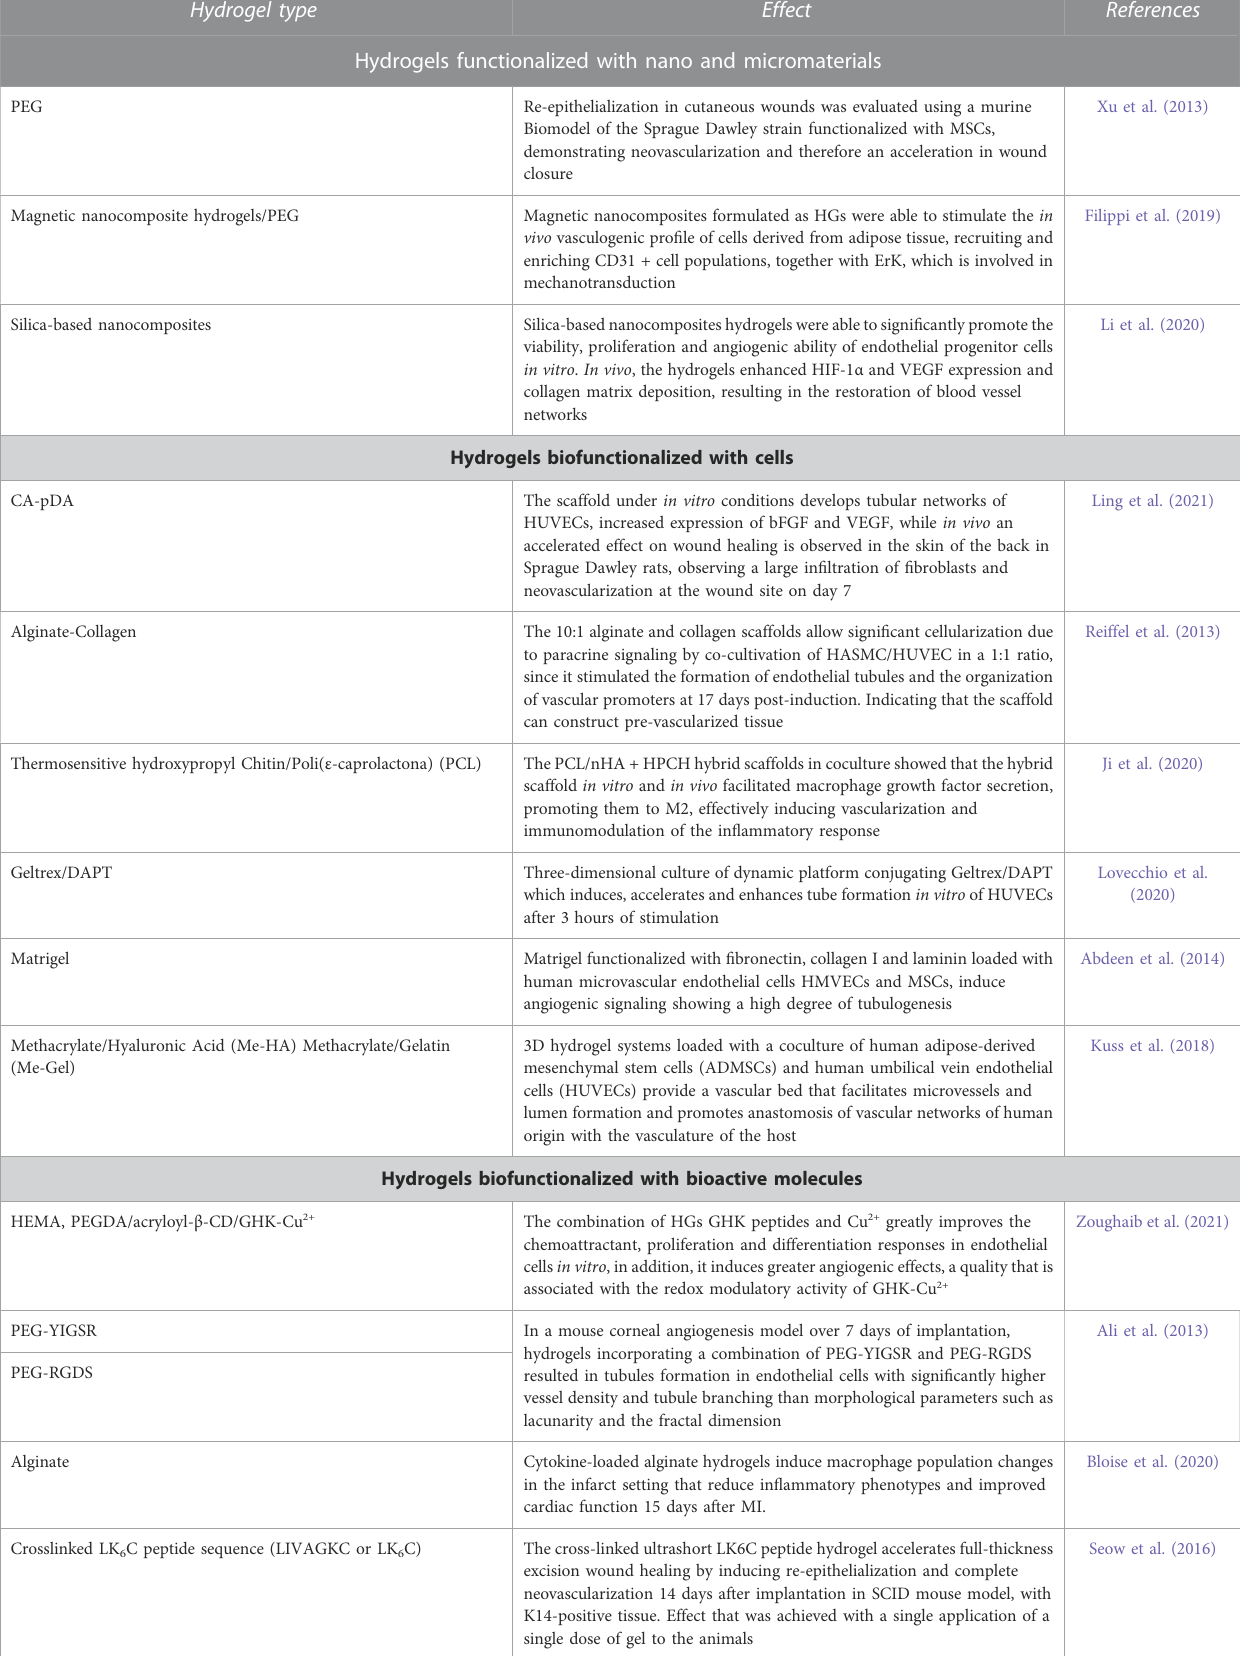
TABLE 2 Hydrogels biofunctionalization for vasculogenesis and